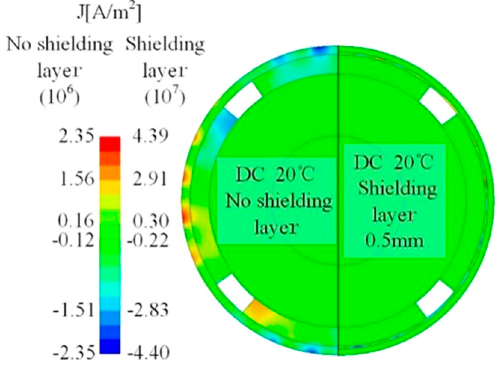
Figure 12. The rotor eddy current-density distribution cloud diagram at room temperature.